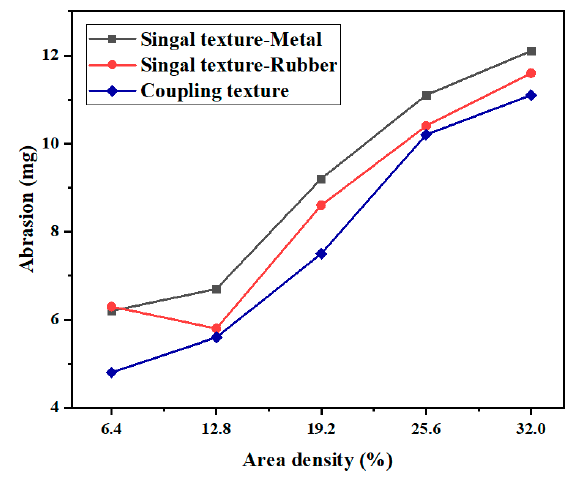
Figure 9. Variation of abrasion with area density.